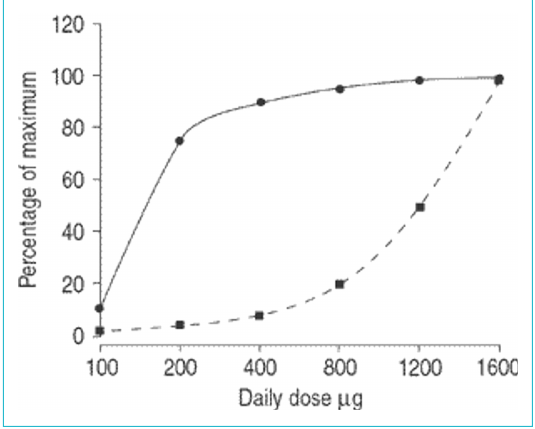
Figure 1: Pulmonary anti-inflammatory effects (—) and undesired systemic side effects (---) if inhaled corticosteroids (ICSs) at differ- ent daily doses. The figure is intended to illustrate the basic princi- ple of these two different dose-response curves. The curves de- picted here belong to a hypothetical ICS; exact values on the X axis may differ between ICSs and patients. (Reproduced with per- mission of the © ERS 2020: European Respiratory Journal.